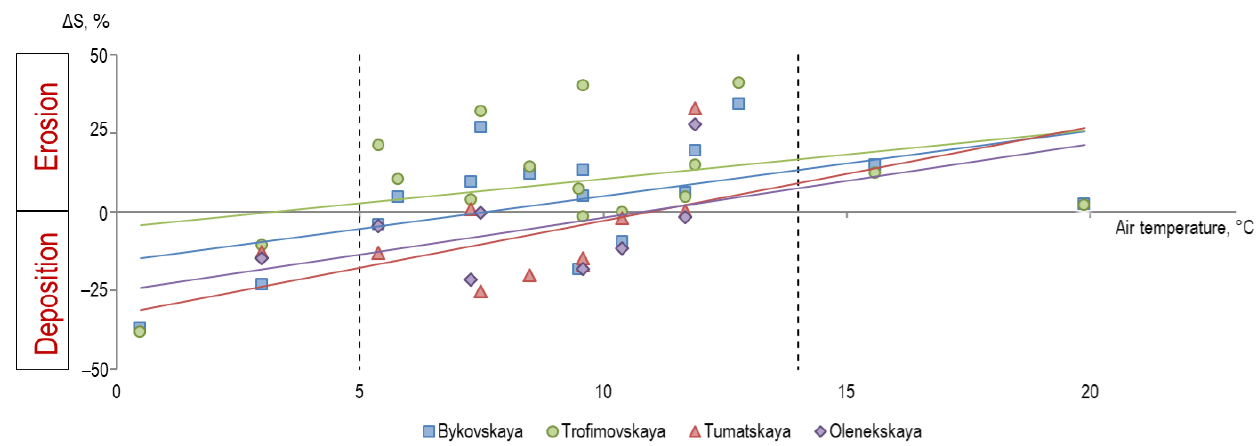
Figure 13. Relationship between the surface suspended sediment changes ( Δ S ) and air temperature ( 0 C ) (Tiksi water station) in the Lena delta.